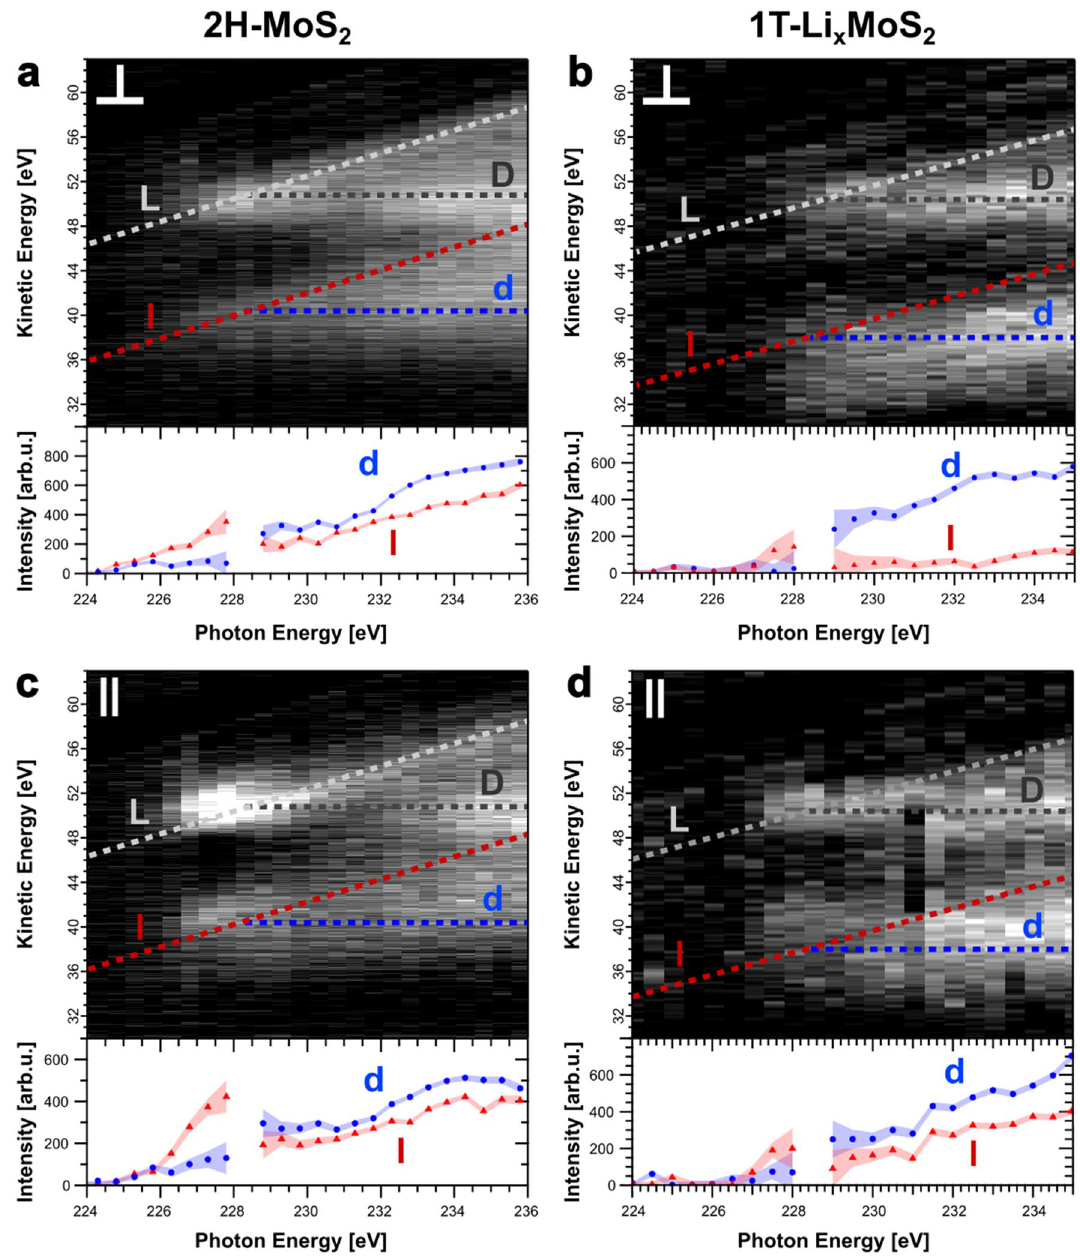
Figure 2. Polarization dependent S L 1 L 2,3 M 1,2,3 CK autoionization spectra as a function of incident X-ray energy for 2H-MoS 2 ( a , c ) and 1T-Li x MoS 2 ( b , d ). The Raman-channels l (S2p − 1 3s − 1 3p 1 ) and L (S2p − 1 3p − 1 3p 1 ) as well as the Auger-channels d (S2p − 1 3s − 1 deloc. 1 ) and D (S2p − 1 3p − 1 deloc. 1 ) are indicated. The symbols (cid:31) and ⊥ denote the selective preparation of in- and out-of-plane S3p excited states. The region of the direct S2p photoionization lines has been subtracted. Below each autoionization spectrum, the spectral intensities of the l- and d-channels are plotted as a function of the photon energy. Error bars represent the uncertainty of each individual